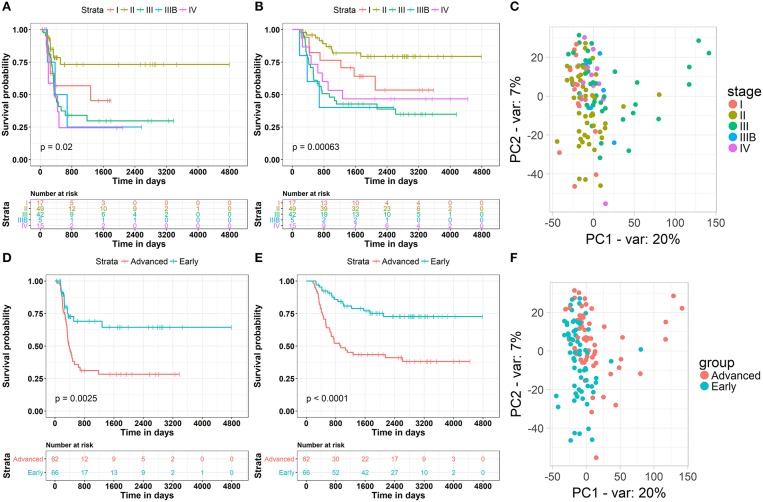
Clinical and gene expression patterns of WT patients at different stages of the disease. (A) Kaplan-Meier curve analysis of the Disease-Free survival rate in WT patients at different stages. (B) Kaplan-Meier curve analysis of the overall survival rate in WT patients at different stages. (C) Principle-component analysis of RNA sequencing (RNA-seq) of WT patients at different stages, percentage of variance (% of var) indicated. (D) Kaplan-Meier curve analysis of the Disease-Free survival rate in WT patients in different groups. (E) Kaplan-Meier curve analysis of the overall survival rate in WT patients in different groups. (F) Principle-component analysis of RNA sequencing (RNA-seq) of WT patients in different groups, percentage of variance (% of var) indicated.